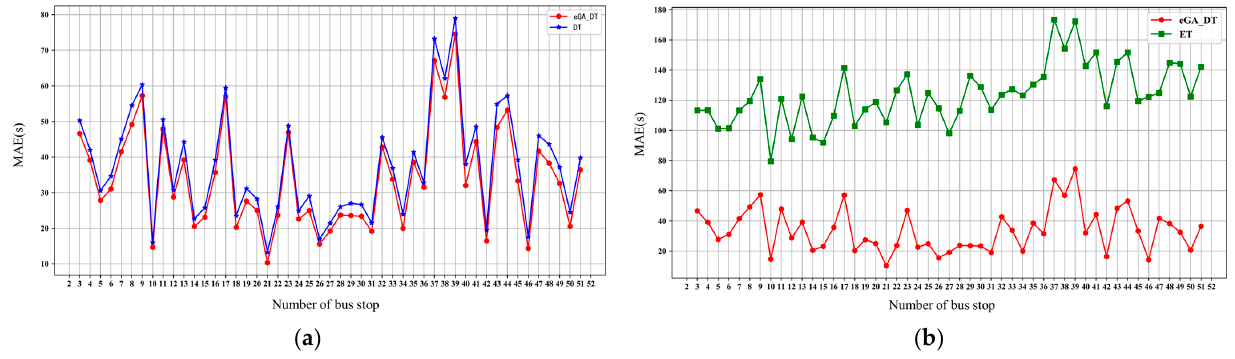
Figure 11. Model comparison by eGA–DT, DT, and ET for different bus stops: ( a ) Comparison result between eGA–DT and DT; ( b ) Comparison result between eGA–DT and ET.